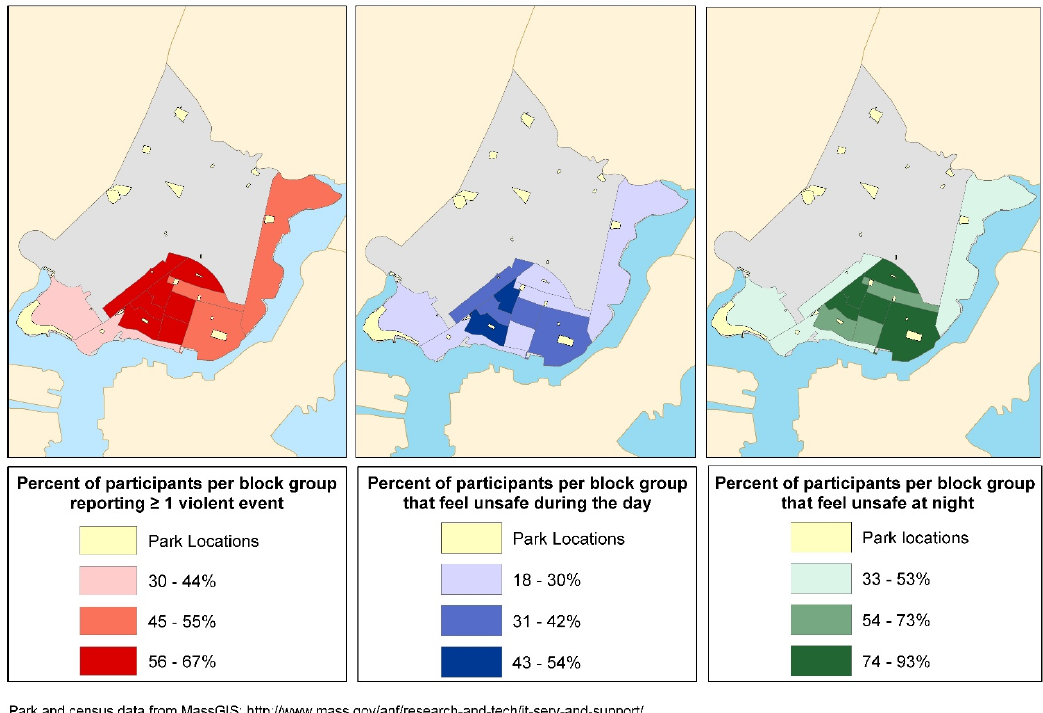
Figure 2. Park locations and perceptions of community violence and safety in Chelsea, MA.